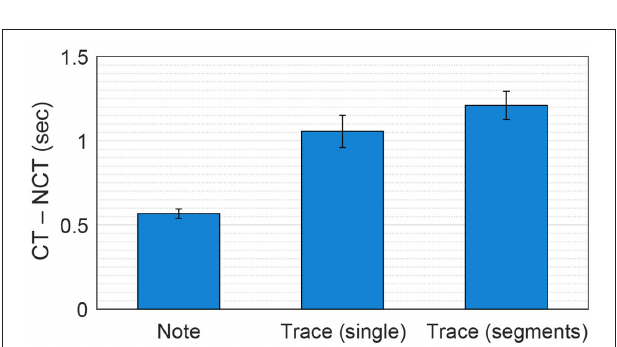
FIGURE 6 | Mean difference between chord pitches and nonchord pitches in note duration, trace duration in single simulations and trace duration in segmented simulations, averaged over all chord spans in the seven Mozart melodies. The error bars indicate standard errors. CT and NCT denote chord tones and nonchord